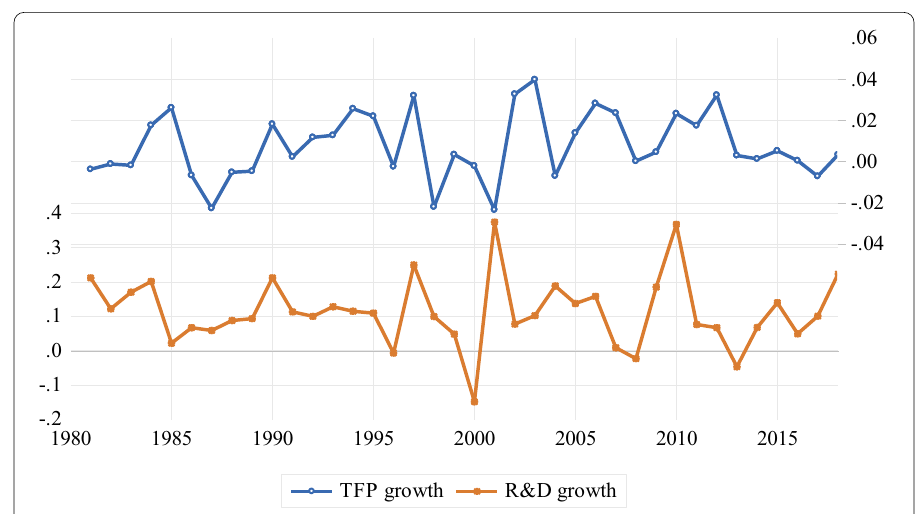
Fig. 1 Sri Lankan TFP and R&D growth from 1980 to 2018. The figure depicts the evolution of TFP and R&D growth in Sri Lanka from 1980 to 2018. The growth in these variables are measured in terms of the first differences of their logarithm. The TFP data is from the Federal Reserve Economic Data (FRED), while the R&D data is from the World Development Indicators (WDI) and the National Science Foundation